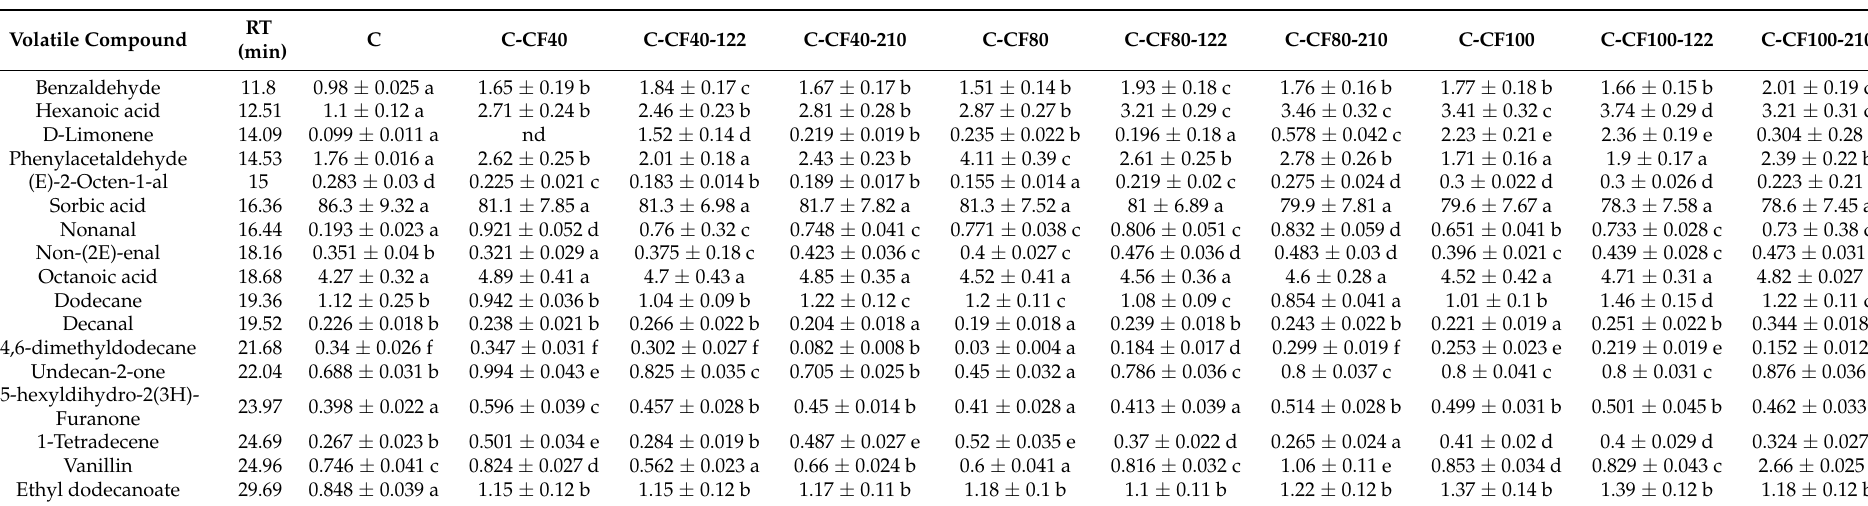
Table 6. Volatile compound (VC) profile of the biscuit samples (percentage of total volatile compound